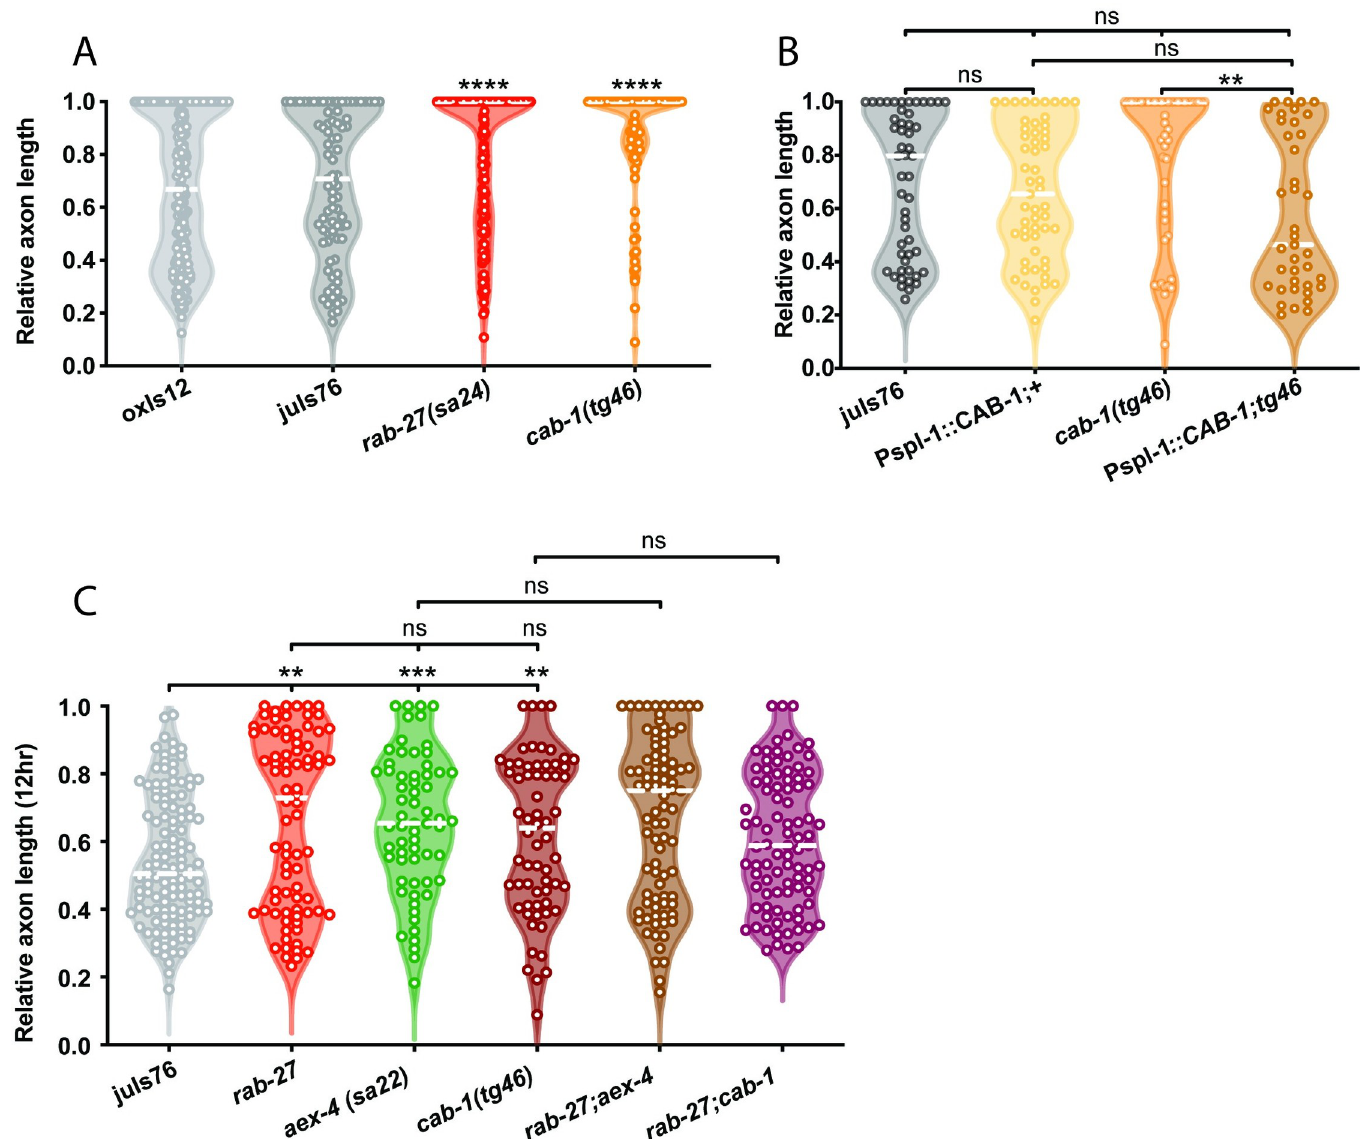
Fig 4. CAB-1 inhibits axon regeneration. (A) Relative axon length in control animals expressing GABAergic neuron-specific GFP ( oxIs12 & juIs76 ), and rab-27 ( sa24 ) and cab-1 ( tg46 ) mutants. rab-27 is compared against oxIs12 , while cab-1 is compared against juIs76 . Axons cut per genotype, L to R: 200, 81, 164, 91. Kolmogorov- Smirnov test was used. ns, not significant, ���� p < 0.0001. (B) Relative axon length in control ( juIs76 ) animals, cab-1(tg46 ) mutants, and animals expressing CAB-1 cDNA under an intestine-specific promoter and stabilized with rab-3 3’ UTR sequence, in both control and cab-1 mutant backgrounds. Number of axons cut per genotype, L to R: 52, 55, 50, 39. Kolmogorov-Smirnov test was used. ns, not significant, �� p < 0.005. (C) Relative axon length in control animals expressing GABAergic neuron-specific GFP ( juIs76 ), rab-27 ( sa24 ), aex-4(sa22) , cab-1(tg46) mutants and rab-27 ( sa24 ); aex-4(sa22) and rab-27(sa24);cab-1 ( tg46 ) double mutants. Axons cut L to R: 127, 80, 63, 64, 87, 90. Kolmogorov-Smirnov test was used. ns, not significant, �� p < 0.005. Regeneration was scored after 12 hours of recovery to more easily visualize enhanced regeneration in the rab-27 and rab-27 ; cab-1 double mutants, which show nearly full regeneration after the usual 24 hour recovery